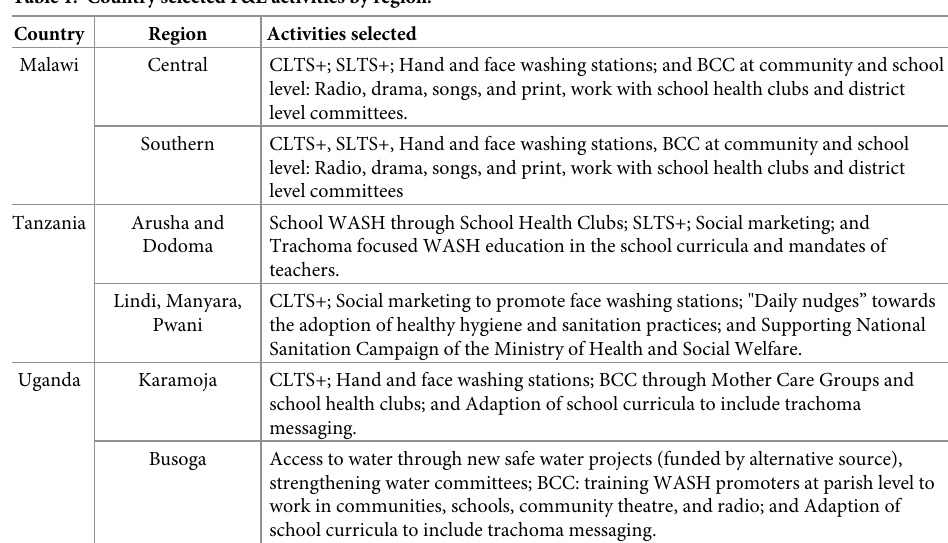
Table 1. Country selected F&E activities by